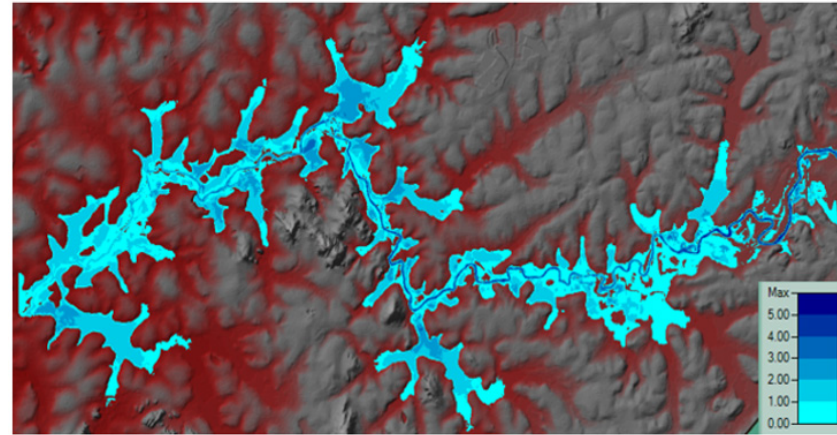
Figure 3: Simulated flood area using HEC-RAS for flood event occurred in May 2018.